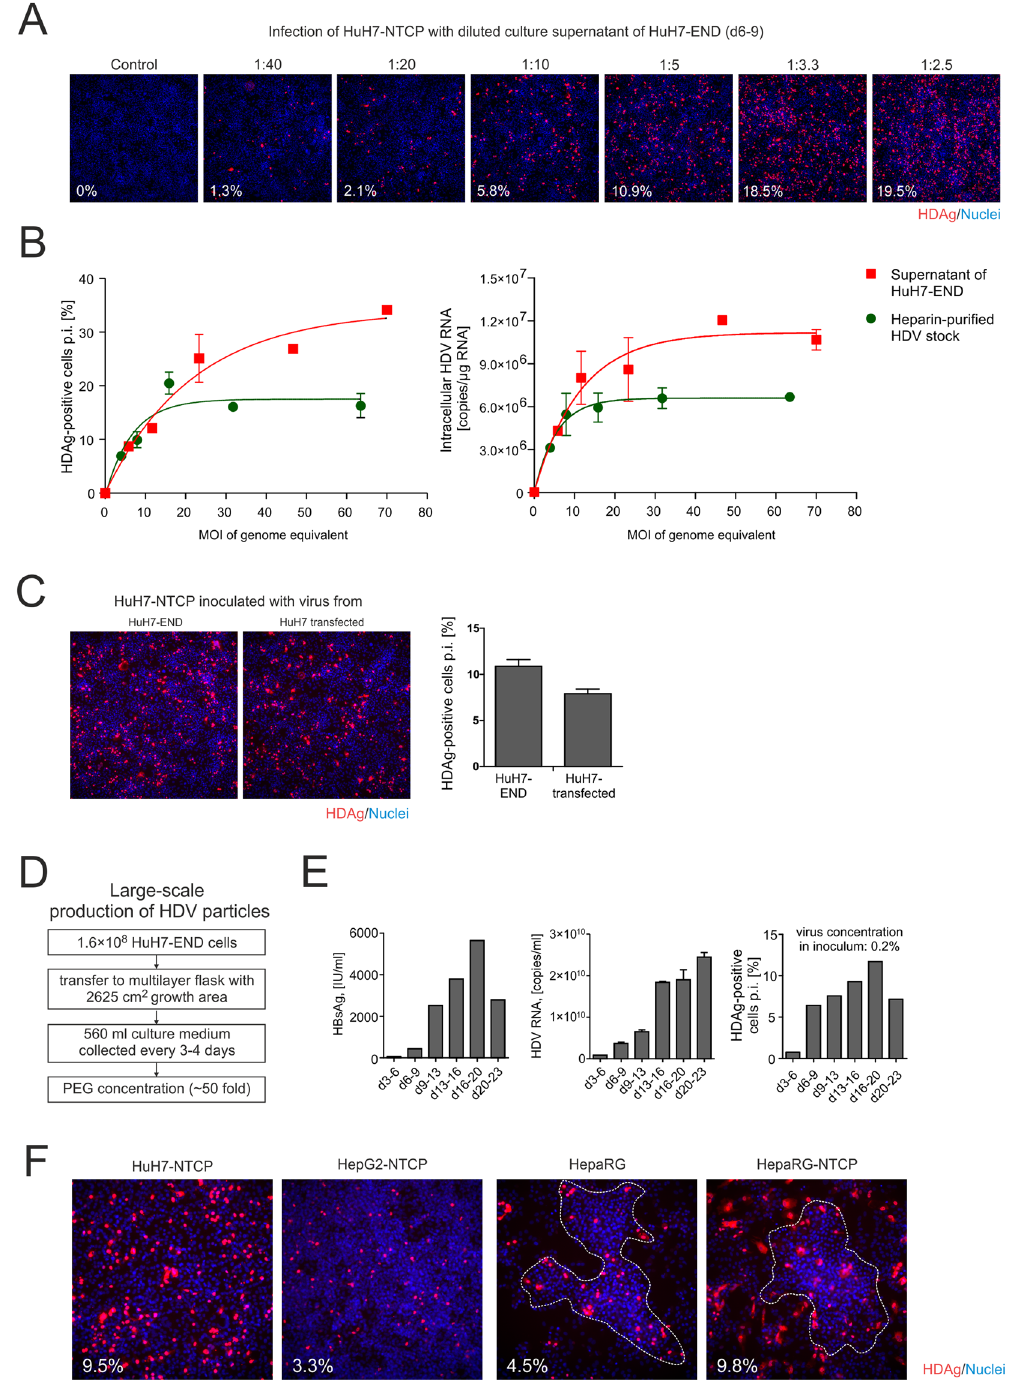
Figure 2. Secretion of infectious HDV particles by HuH7-END cells. ( A ) HDAg-specific IF of HuH7-NTCP cells inoculated with different dilutions (1:40 to 1:2.5) of cell culture supernatants collected from HuH7- END cells between day 6–9 post seeding. HDAg-positive cells after infection were counted and depicted on the left corner of pictures. ( B ) HuH7-NTCP were infected with the culture supernatant of HuH7-END cells or a different source of HDV (heparin-column purified) at different MOI of HDV genome equivalents. The HDAg positive cells were counted (left) and the intracellular HDV RNA (right) were measured at 5 days post- infection. ( C ) Comparison of infectivity of HuH7-END derived HDV with virus obtained from co-transfection of HuH7 cells with pSVLD3 and pT7HB2.7: IF of HDAg in HuH7-NTCP cells after infection with cell culture supernatant of HuH7-END cells (collected between d6-9 post seeding and diluted 1:10) and SN (collected day 10–12 post transfection and diluted at 1:10) Infection rates were quantified by counting HDAg positive HuH7- NTCP cells at day 5 p.i. as shown on the right. ( D ) Scheme of large scale production and concentration of virus stocks produced from HuH7-END cells. ( E ) Characterization of concentrated virus stocks (according to